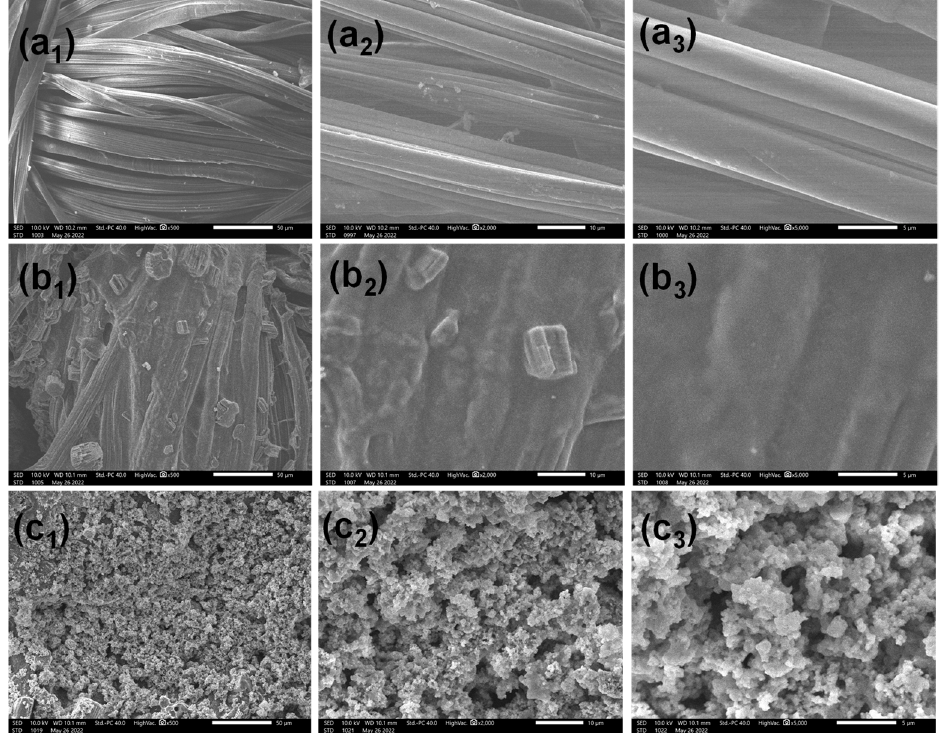
Figure 2. SEM images of pristine cotton ( a 1 – a 3 ), CH/APP cotton ( b 1 – b 3 ), CH/APP@TiO 2 -SiO 2 - HMDS cotton ( c 1 – c 3 ).